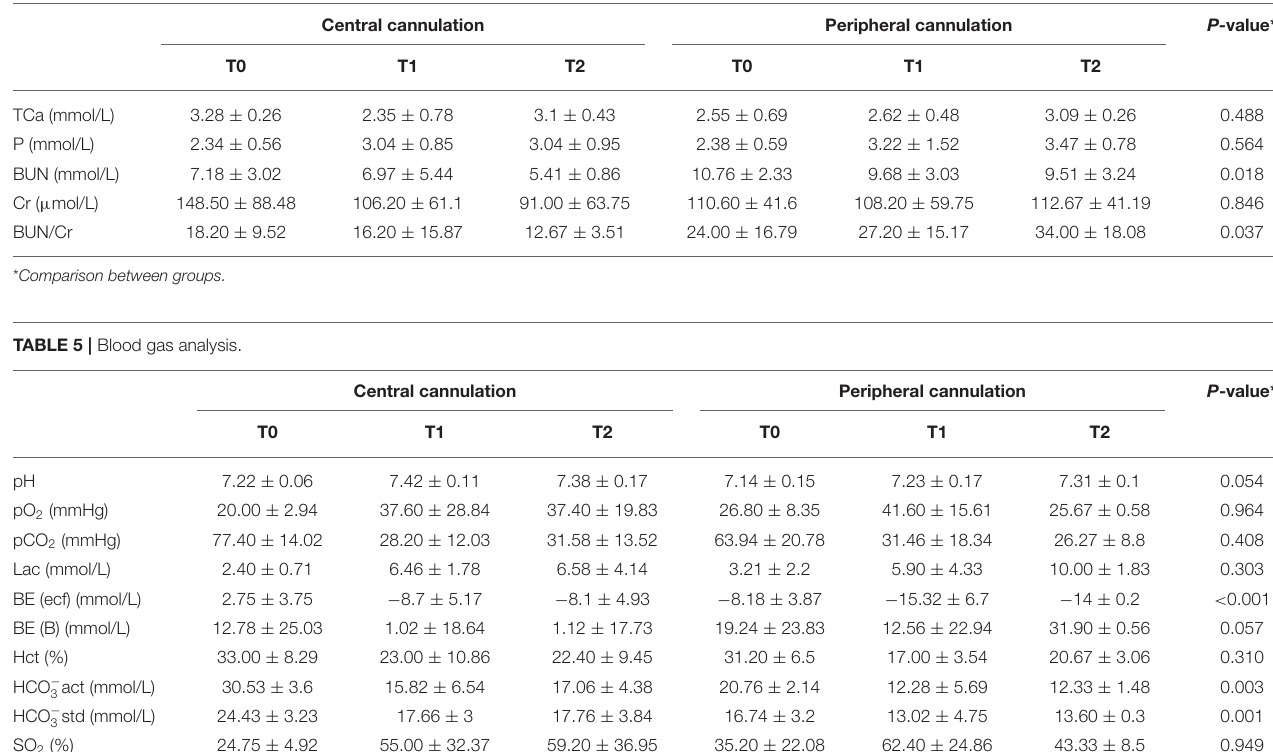
TABLE 4 | Renal function test.